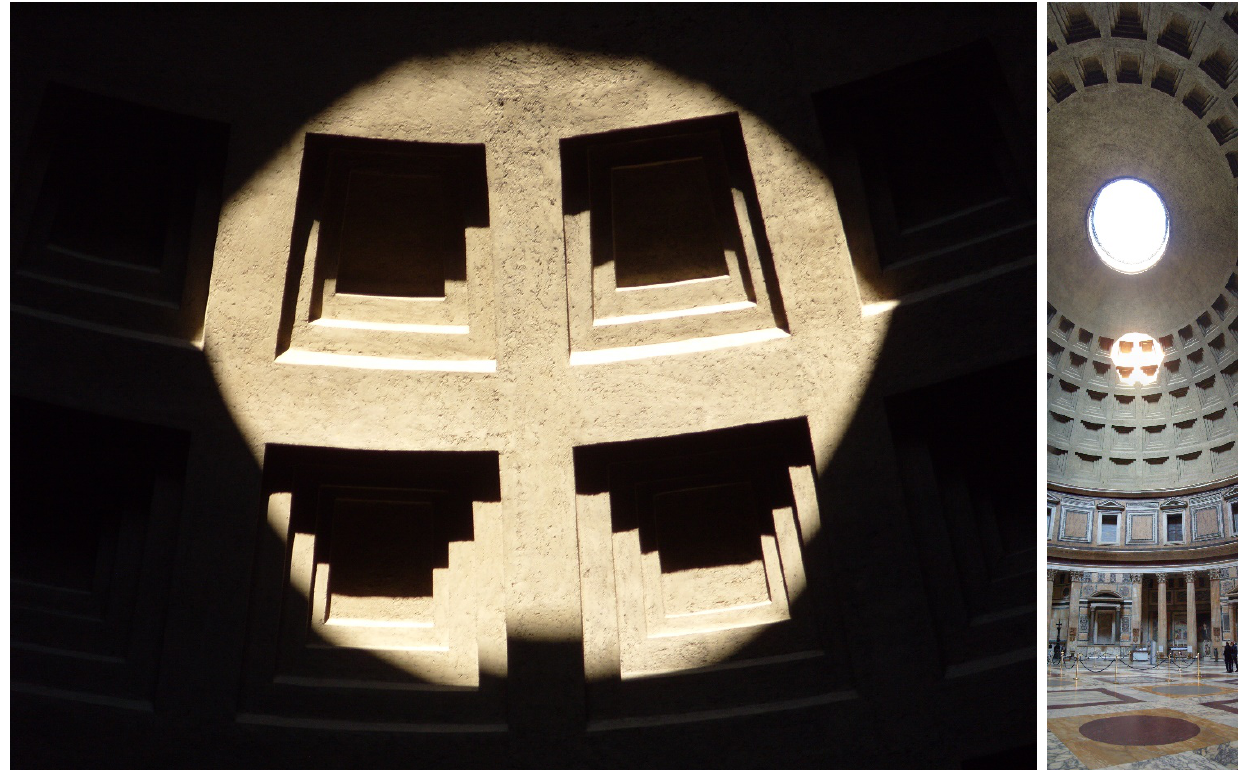
Figure 7. The theatrical play of light that penetrates through the dome’s central oculus helps reticent onlookers enter into a contemplative state ( left ). The contrasts between light and shadow on the cascading profiles of the ceiling coffers fix the attention of visitors ( right ). Photographs by author.